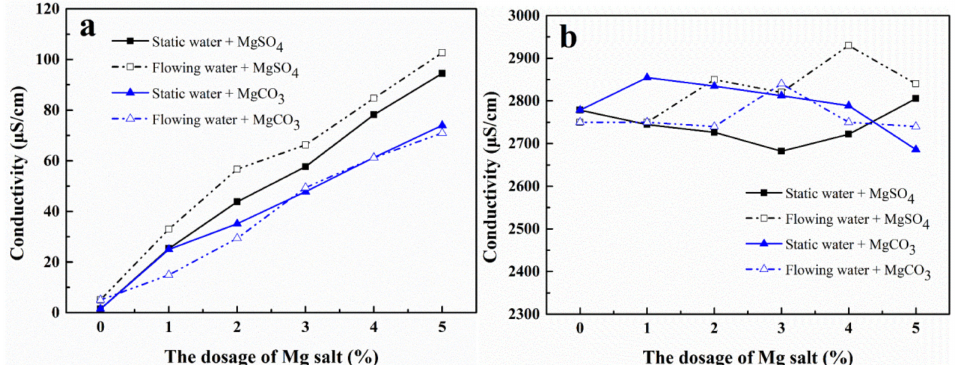
Figure 3. The e ff ects of the concentration of magnesium salts on the conductivity of the solution for both static and flowing water. ( a ) magnetized distilled water;( b ) magnetized calcium chloride sodium bicarbonate solution;